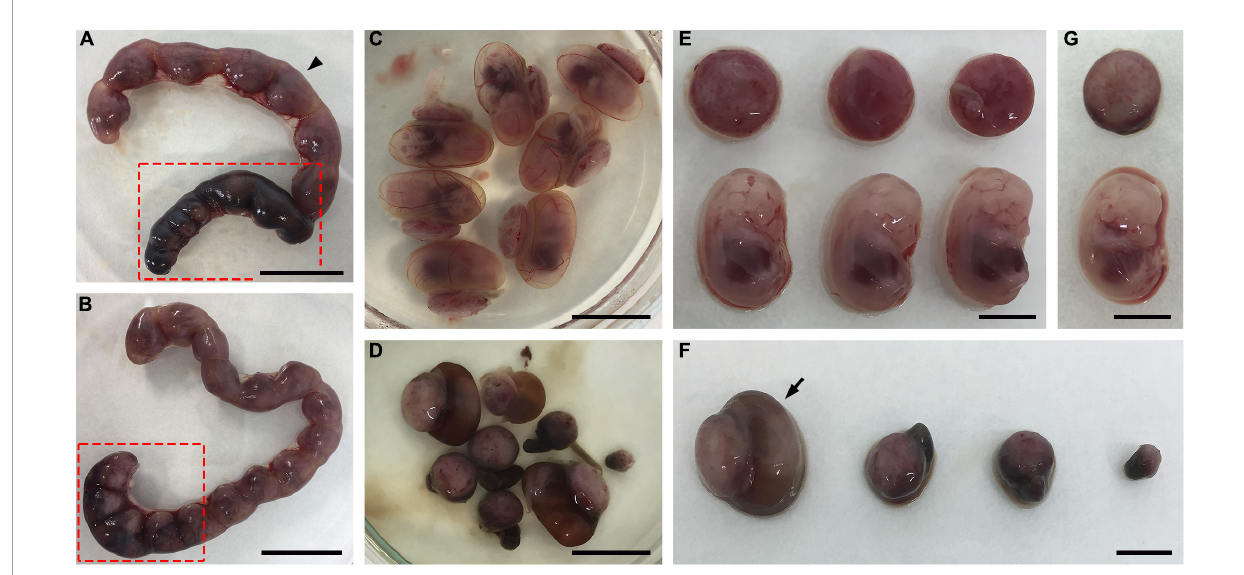
FIGURE2 Effects of T. gondii infection in outbred Swiss Webster mice during pregnancy. (A–G) Pregnant dams were infected with 10 7 tachyzoites of the ME49 strain at E8.5 or E9.5 and euthanized at E13.5 or E14.5. (A,B) Uteri of two different infected mice exhibiting abnormal uterine horns with regions of atrophy and heavy hemorrhage (dark regions highlighted in red box). (C,D) Macroscopically normal (C) and abnormal (D) fetoplacental units were obtained from the superior (arrowhead) and inferior (red box) uterine horns shown in panel (A) , respectively. (E) Fetuses and placentas from panel (C) are apparently healthy. (F) The fetoplacental units in panel (D) show different degrees of resorptions. (G) A fetus taken from the fetoplacental unit indicated with an arrow in panel (F) is apparently normal, while its corresponding placenta is pale brown as opposed to the bright red seen in panel (E) . The scale bars indicate 2.0 cm (A,B) , 1.0 cm (C,D) , and 0.5 cm (E–G)